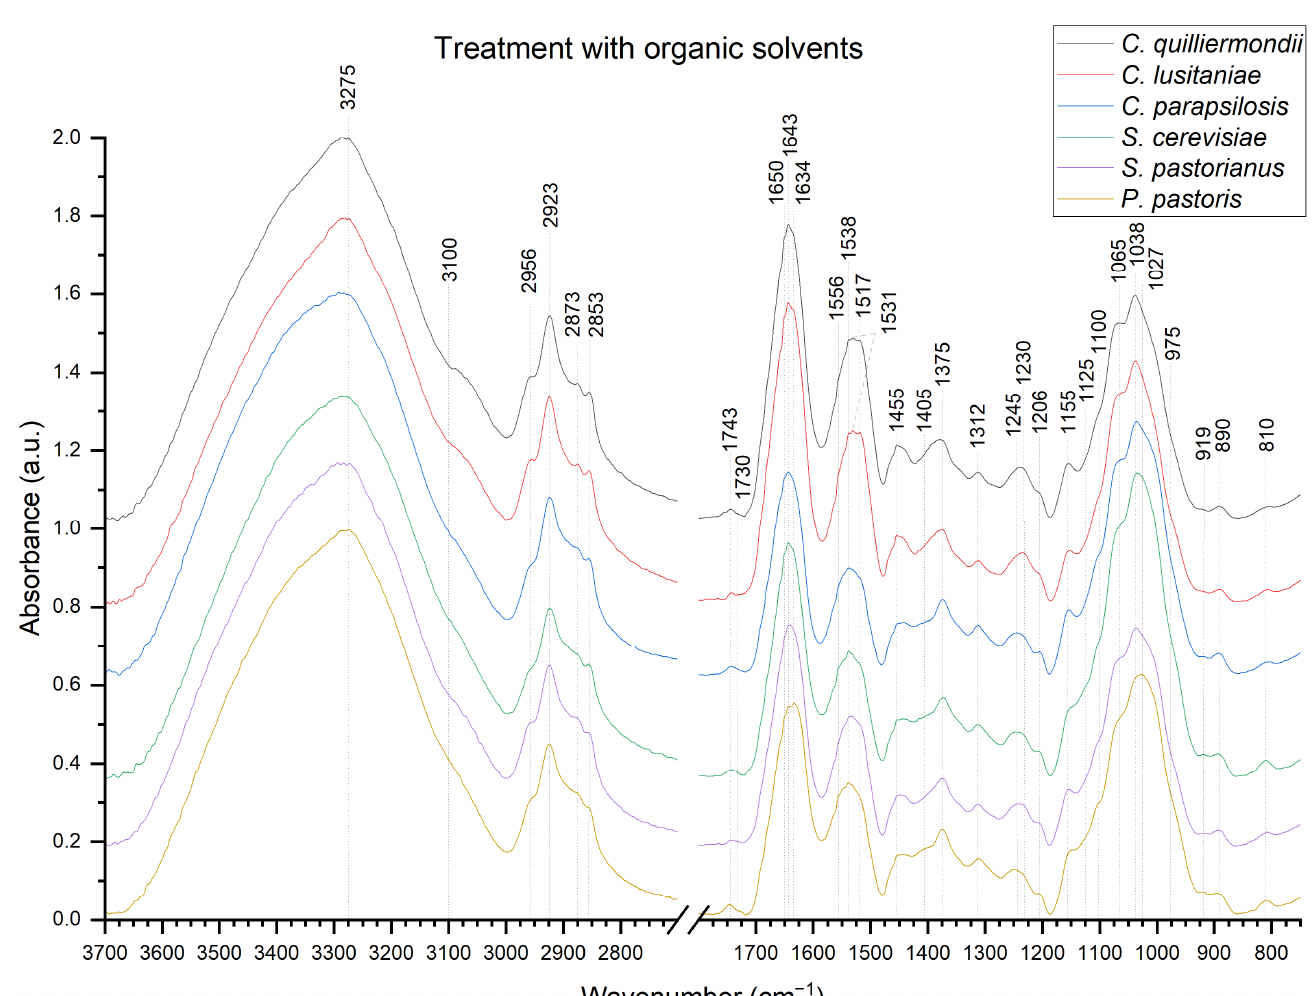
Figure 3. ATR IR absorption spectra of hot water-extracted β -glucans treated with organic solvent (EtOH) from different yeast strains: (from top to bottom) C. guilliermondii , C . lusitaniae , C . parapsilosis , P. pastoris , S. cerevisiae and S . pastorianus.